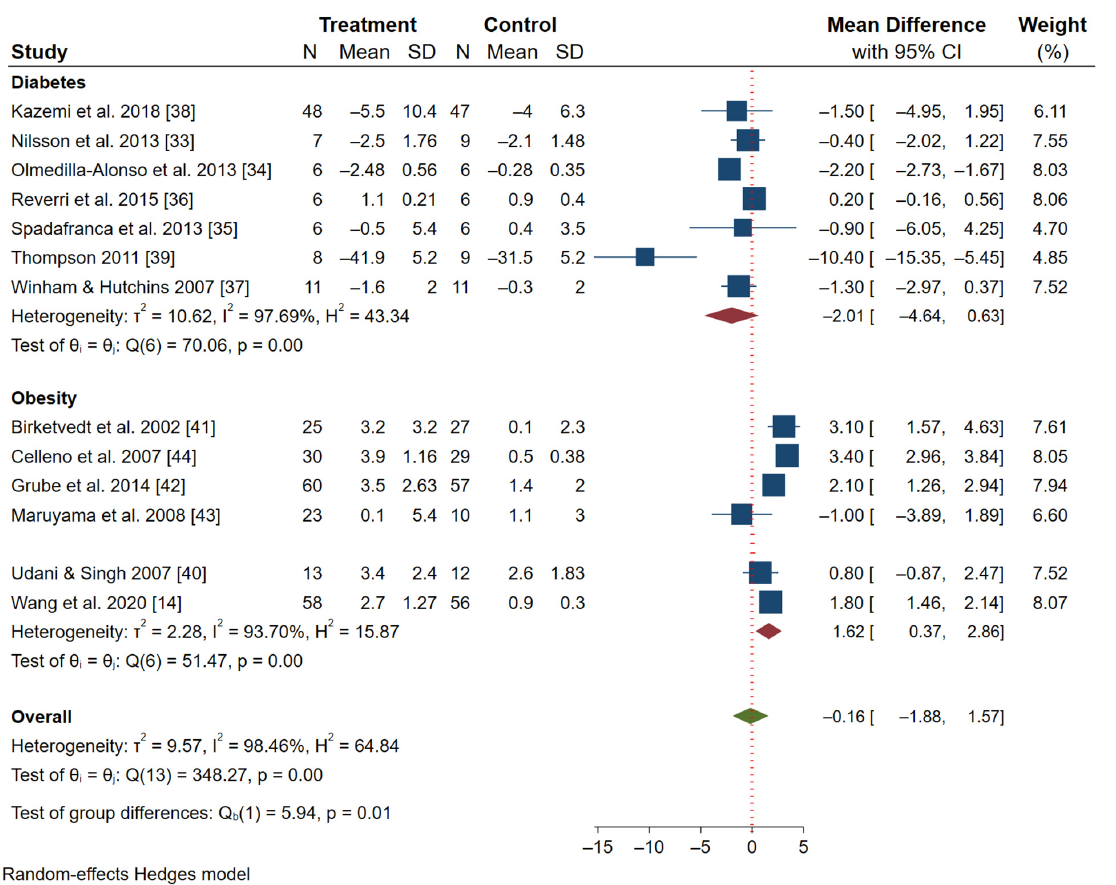
Figure 2. Forest plot empirical estimation of study impact for diabetes and obesity health issues. The horizontal red “line of null effect” for these studies indicates that most of the studies crossed the line, meaning they had little to no effect and do not illustrate a statis- tically significant result. The diamond shape indicates the general significant effect of the studies combined.